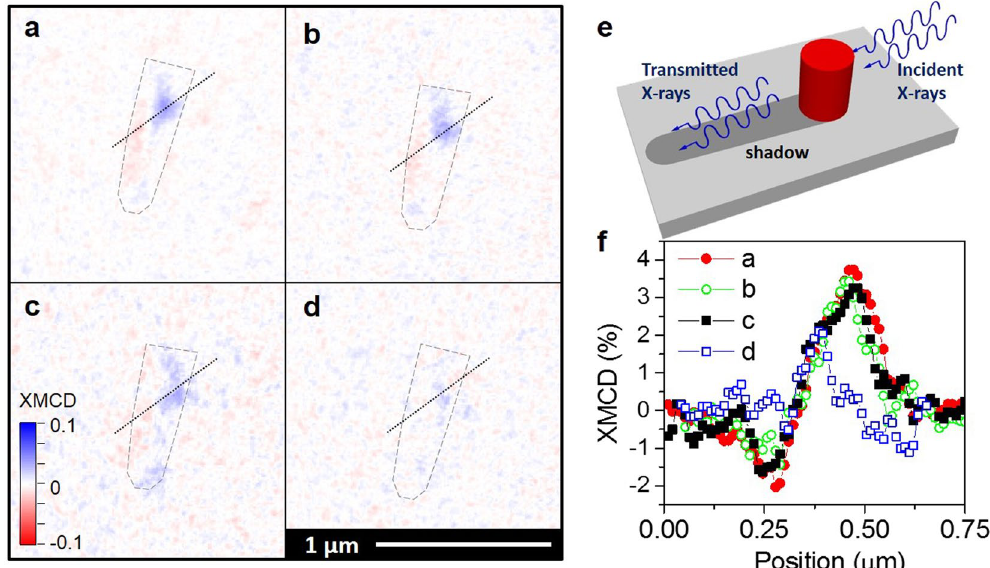
Figure 5. XMCD magnetic images. Magnetic structure obtained in remanence for a single Co nano-rod ( a ) at 300 K after a maximum applied field of − 100 mT, ( b ) at 300 K, − 50 mT, ( c ) at 65 K, 50 mT-ZFC, i.e. removing the magnetic field T > T c , and ( d ) at 65 K, 50mT-FC, applying and removing the magnetic field at 65 K. The colour bar indicates the direction of the magnetic contrast along the nano-rod axis in arbitrary units. Dotted lines indicate the position of the shadow. ( e ) Schematic of the T-XPEEM measurement (f) XMCD contrast profiles along the dotted line depicted in the XMCD images.